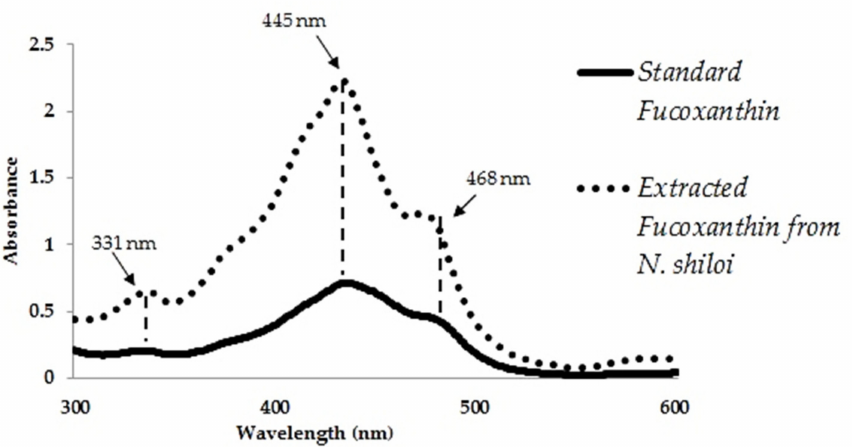
Figure 3. UV-vis spectroscopy of extracted fucoxanthin from N. shiloi and standard